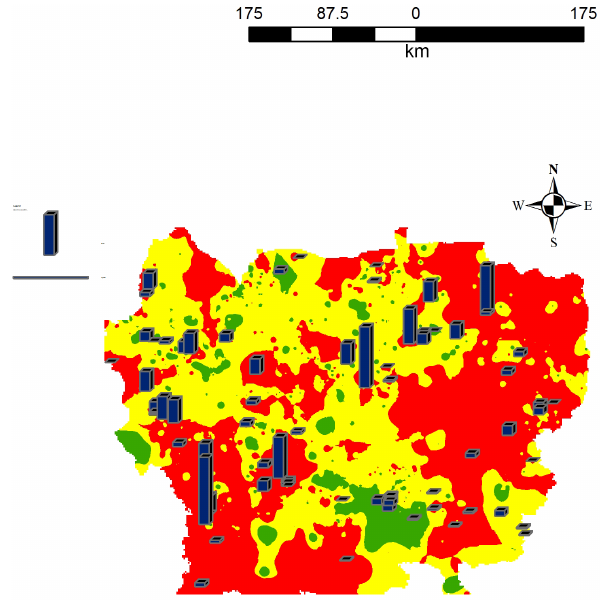
Figure 16. Nitrate distribution in the fuzzy model.